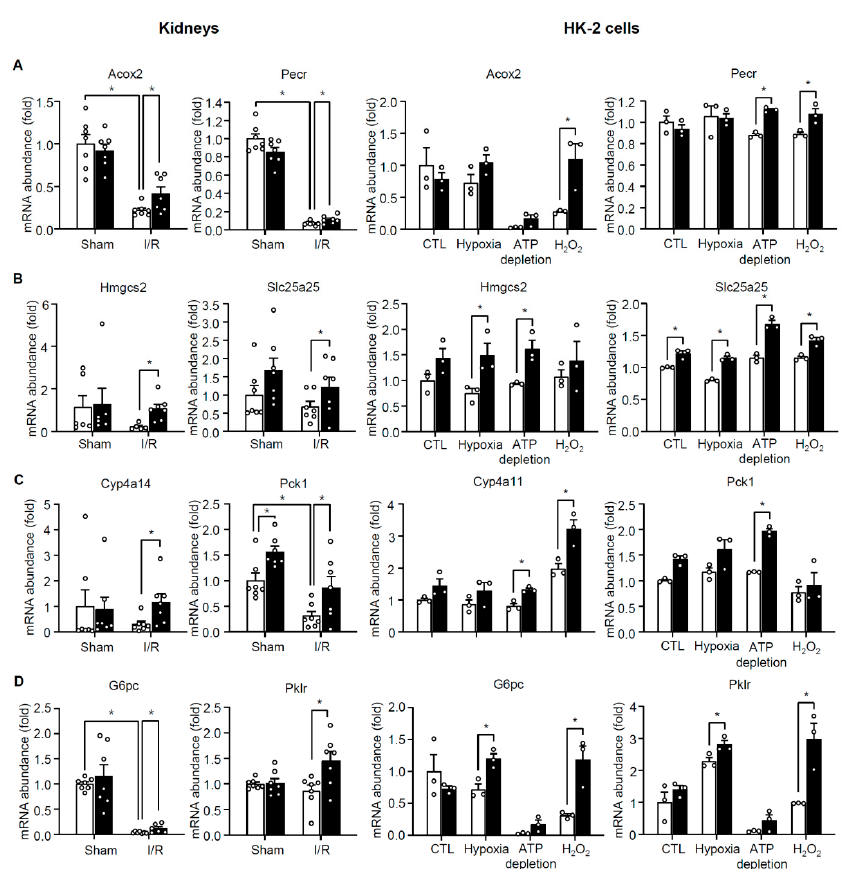
Figure 9. RT-qPCR analyses of kidneys (left) and HK-2 cells (right) for selected genes in the clusters shown in Table 2: ( A ) peroxisome, ( B ) mitochondrial inner membrane, ( C ) PPAR signaling pathways, ( D ) glycolysis/gluconeogenesis. Kidneys were isolated from TonEBP +/ Δ (filled bars) mice and their TonEBP +/+ littermates (open bars) after I/R or sham treatment. HK-2 cells were transfected with scrambled (open bars) or TonEBP-targeted siRNA (filled bars) followed by treatment with hypoxia (1% O 2 ), ATP depletion (10 µ M of A.A. and 10 mM of 2-DG) or 0.5 mM H 2 O 2 for 3 h. Mean + SEM, * p <